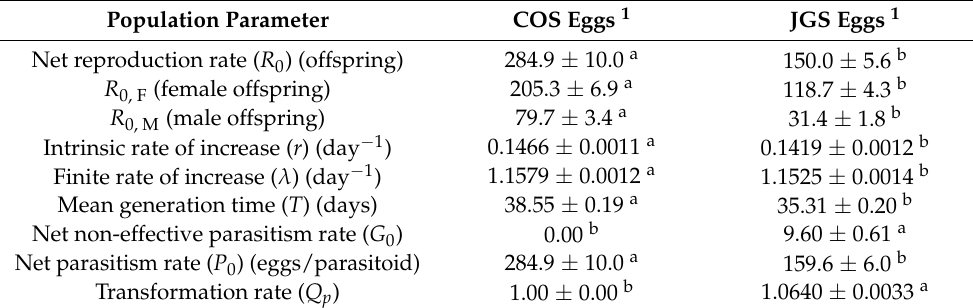
Figure 4. Reproductive values ( v xj ) of Anastatus japonicus parasitizing COS and JGS eggs. 3.4. Population Parameters of A. japonicus Parasitizing COS and JGS Eggs The population demographic parameters of A. japonicus parasitizing COS and JGS eggs are shown in Table 2. The net reproduction rate ( R 0 ), intrinsic rate of increase ( r ), finite rate of increase ( λ ), and mean generation time ( T ) of A. japonicus parasitizing COS eggs were all significantly higher than those parasitizing JGS eggs. There were significant differences in the numbers of female and male offspring produced between parasitoids parasitizing COS eggs and JGS eggs. The net non-reproductive parasitism rate ( G 0 ) on COS eggs was zero. The total net parasitism rate ( P 0 ) (that was the sum of female and male offspring and the net non-reproductive parasitism) was higher on the COS than JGS eggs. The transformation rate ( Q p ) was significantly lower on the COS than JGS eggs. Table 2. Population parameters of Anastatus japonicus parasitizing COS and JGS eggs. Population